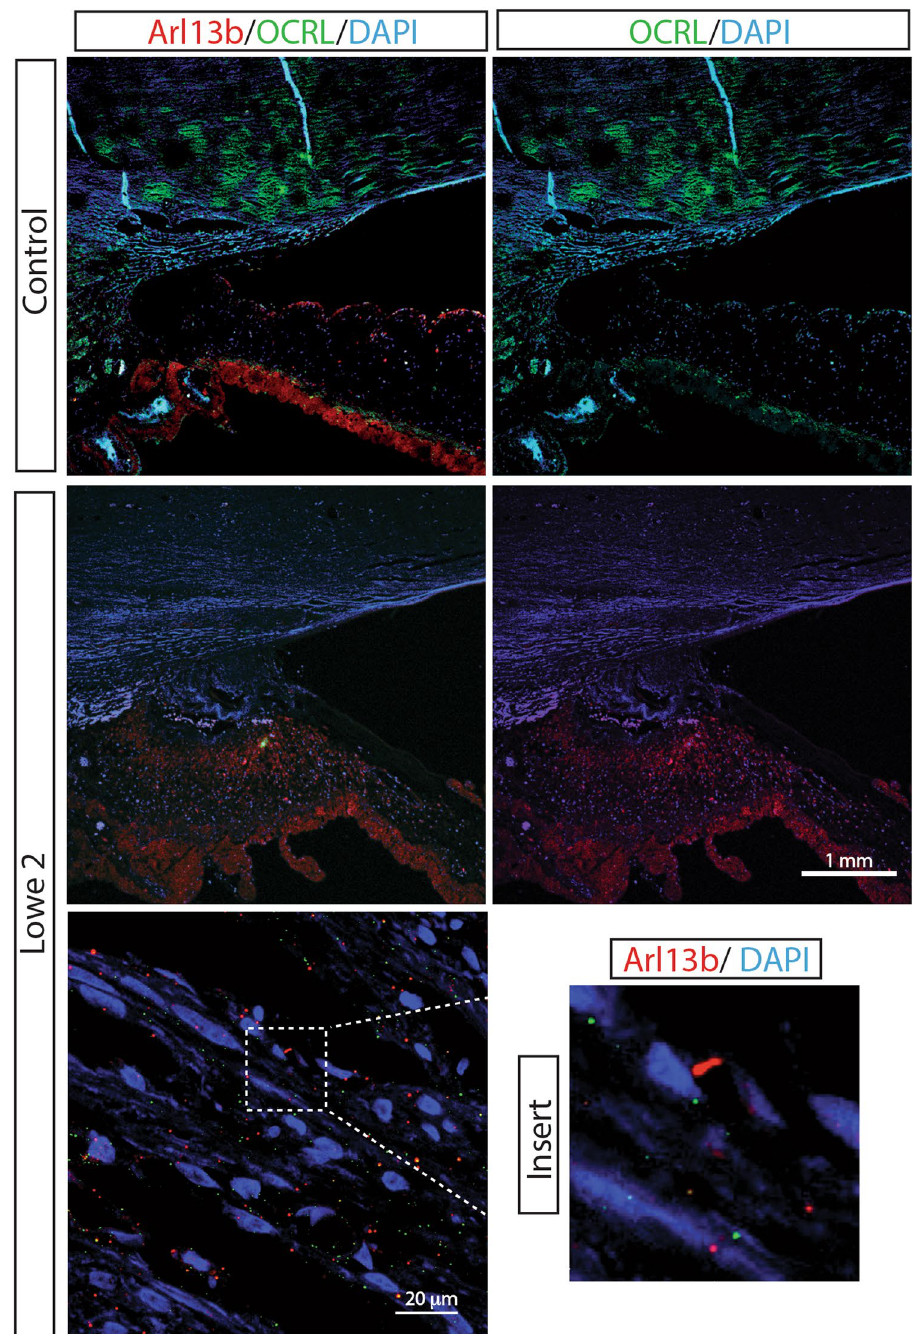
Figure 3. Absent OCRL staining in ocular tissue of Lowe patient 2. Immunofluorescence analysis of the trabecular meshwork in normal human eye (control) and the eye from Lowe patient 2, both stained for Arl13b (red) and OCRL (green), DAPI staining in blue. Scale bar 1